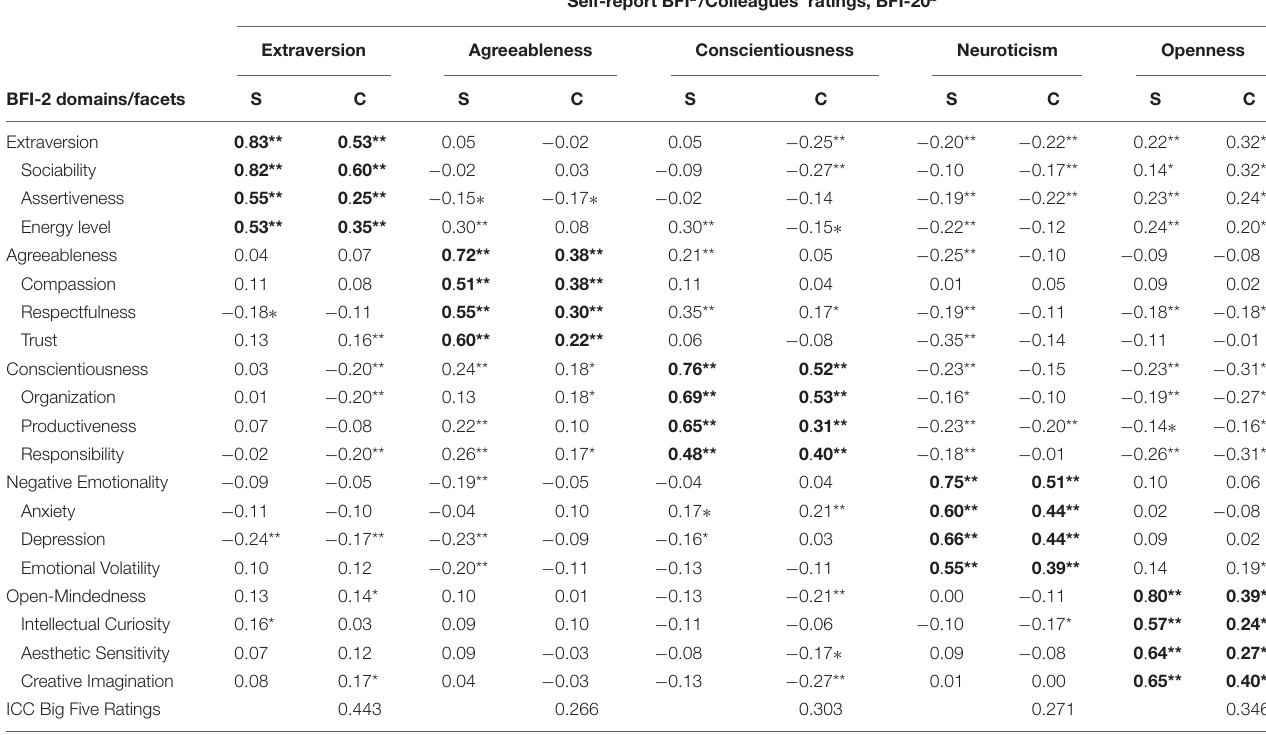
TABLE 5 | BFI-2 scores and their correlations with self-ratings on BFI and colleagues’ ratings on